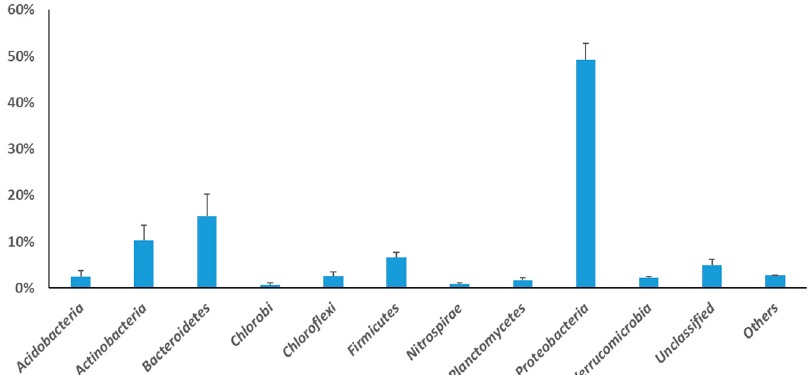
Figure 2. Averaged microbial community composition at a phylum level. Only the phyla showing abundance higher than 1% in at least one sample are presented, the remaining microbial phyla were grouped as others. Table 1. Percentage of the microbial community representatives and their physiological function at a specified taxonomical level. AOB, ammonium oxidizing bacteria; NOB, nitrite oxidizing bacteria. Physiological Function in Biomass